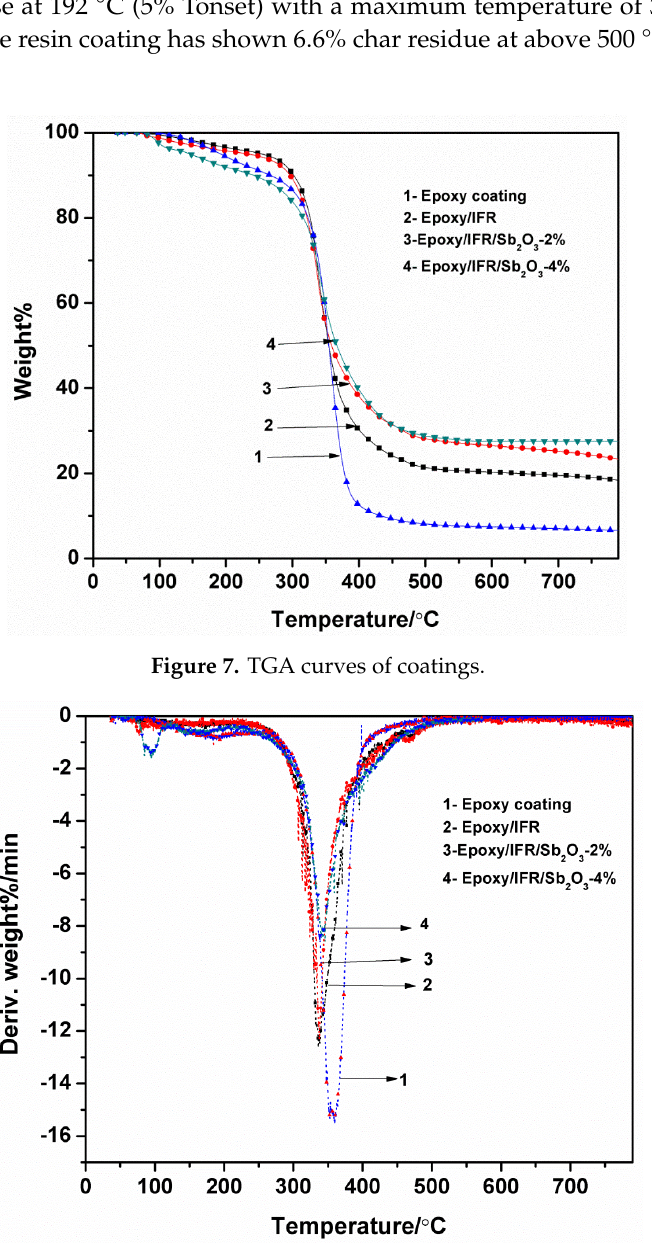
Figure 8. DTG curves of coatings.